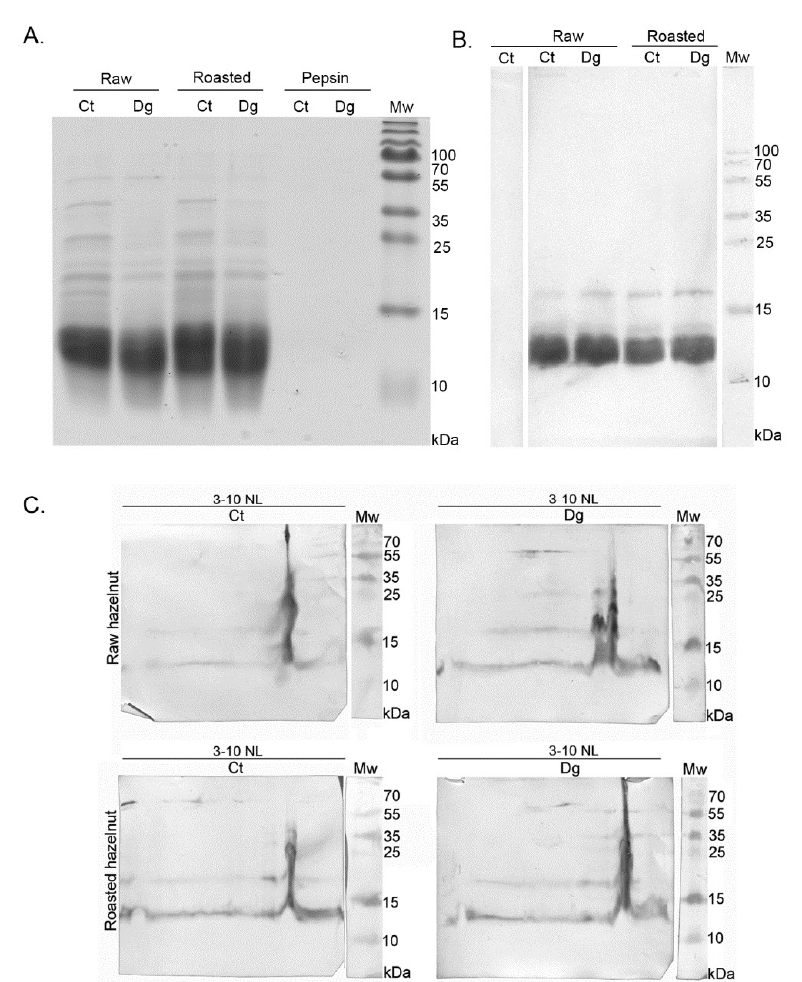
Figure 6. ( A ) 1D SDS-PAGE (14%) protein profiles of non-defatted raw and roasted hazelnut gastric digesta and their corresponding controls. SDS-PAGE was performed in reducing conditions, corresponding to western blot analysis; ( B ) 1D western blot probed with Cor a 8 specific antibody on resolved raw and roasted hazelnut gastric digesta and their controls in reducing conditions; ( C ) 2D western blot probed with Cor a 8 specific antibody on resolved raw and roasted hazelnut gastric digesta and their controls in reducing conditions; Ct—control sample, Dg—gastric phase; Mw—molecular weight markers; kDa—Kilo Daltons; 3–10 NL—nonlinear pH range.